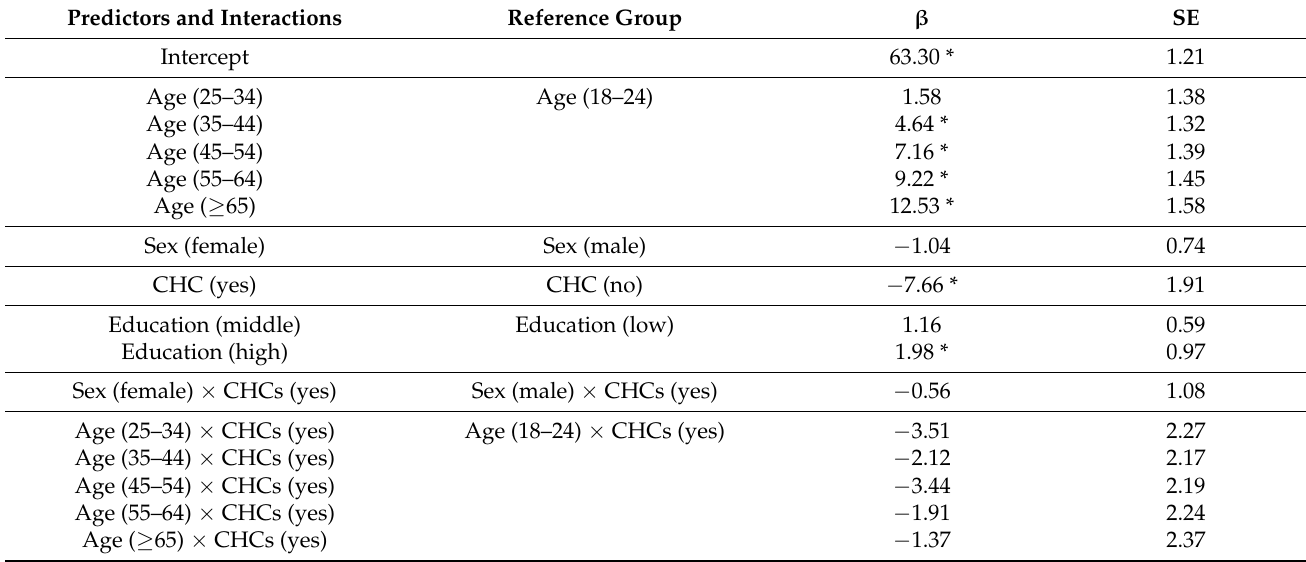
Table 7. Results of the linear regression